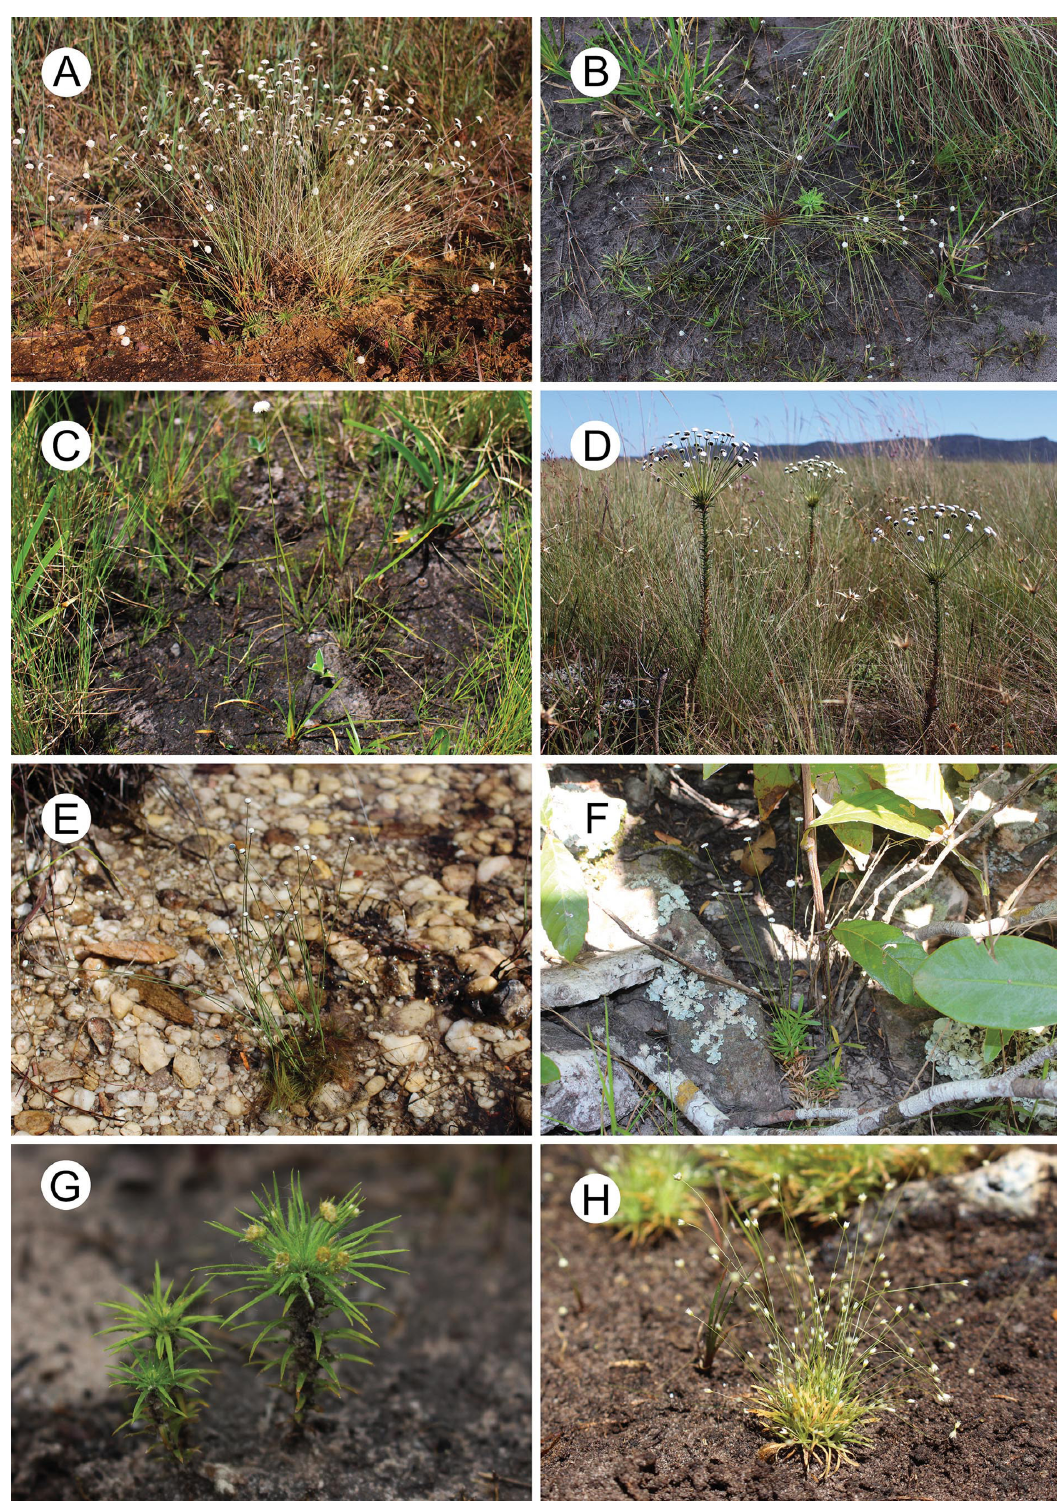
Fig. 6 . Species of Paepalanthoideae (Eriocaulaceae) from the Chapada dos Veadeiros National Park. A . Actinocephalus brevifolius Trovó & Echtern. sp. nov. B . A. phaeocephalus (Ruhland) F.N.Costa. C. Comanthera dimera Echtern.. D . Paepalanthus acanthophyllus Ruhland. E . P. amphibius